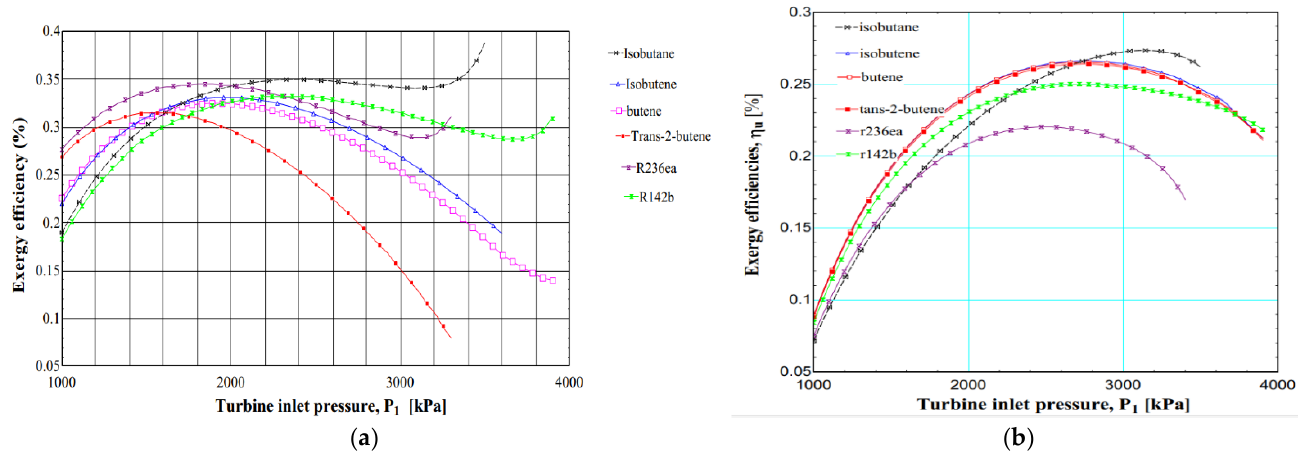
Figure 5. Effect of turbine inlet pressure on the exergy efficiencies of the binary cycles ( a ) for simple ORC showing optimum pressures between 1500 and 2000 kPa and ( b ) for the regenerative ORC cycle illustrating the trend of optimum pressures between 2000 and 3000 kPa.